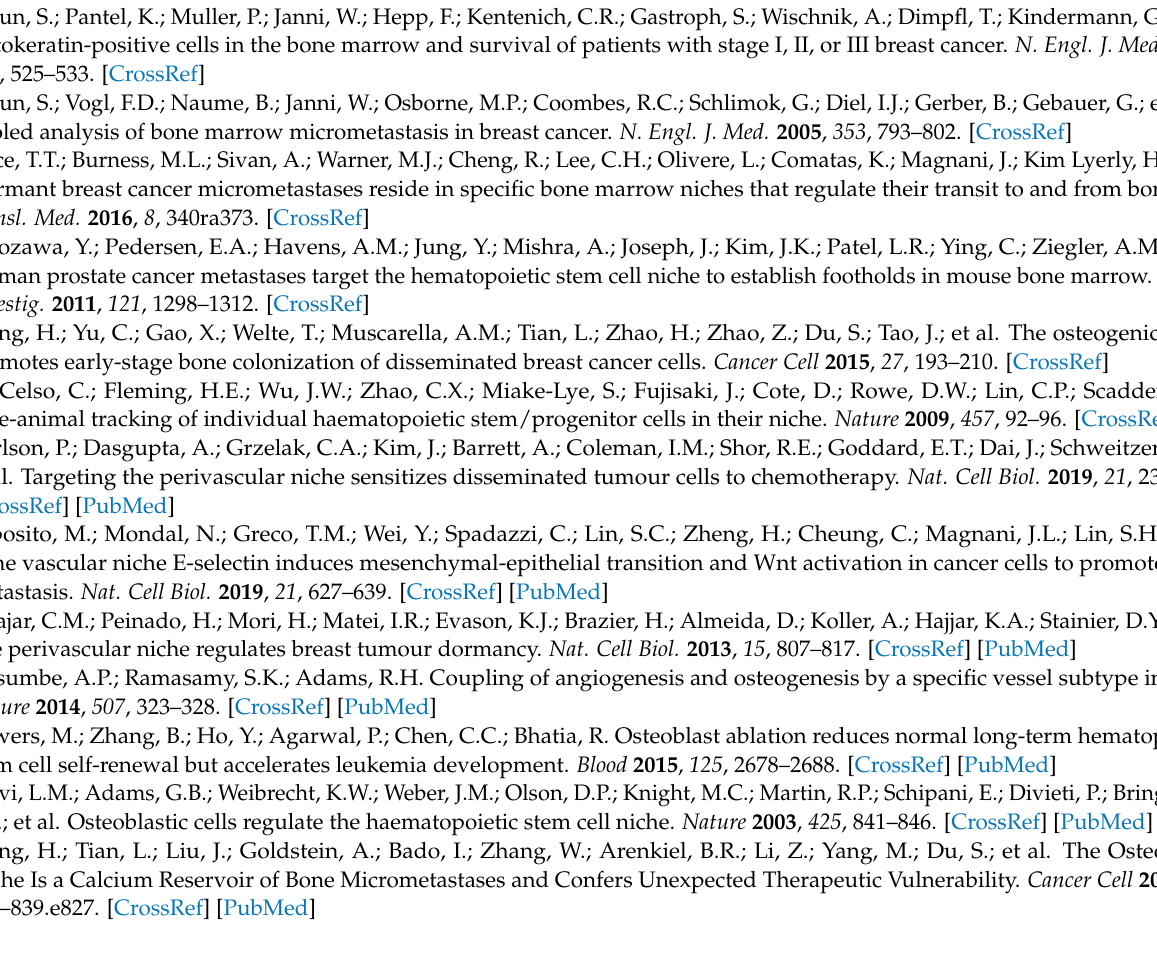
serum deprivation-induced cell death. Table S1: Gene expression profiling data. Table S2: Reagents list and supplier